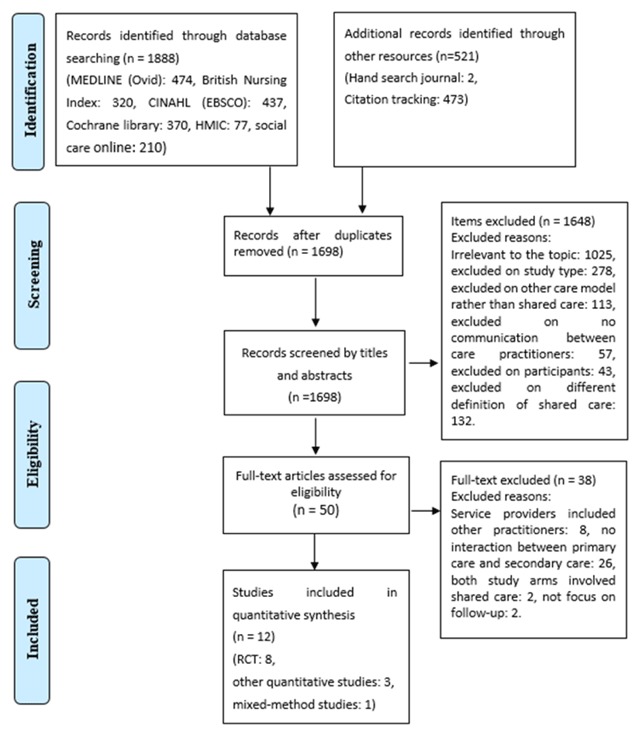
PRISMA flow diagram.